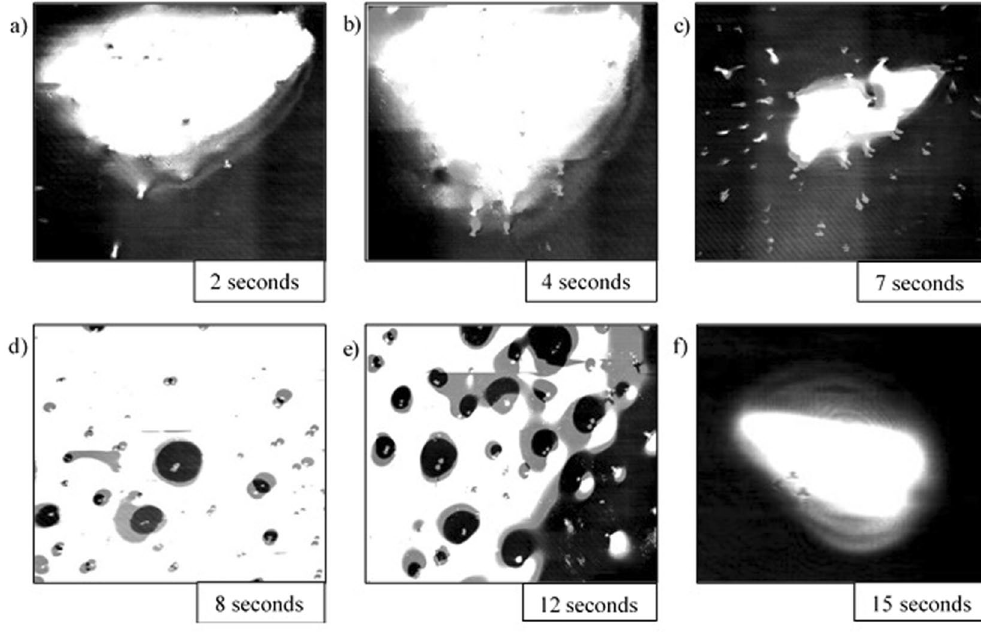
Figure 4. Time step images of the 5% FeAl experiment as seen in the HT-CSLM. In focus metal phases appear as lighter in grey scale and the molten metal oxide phase is seen as black. ( a–f ) Shows the cycle of perturbation- emulsification and finally